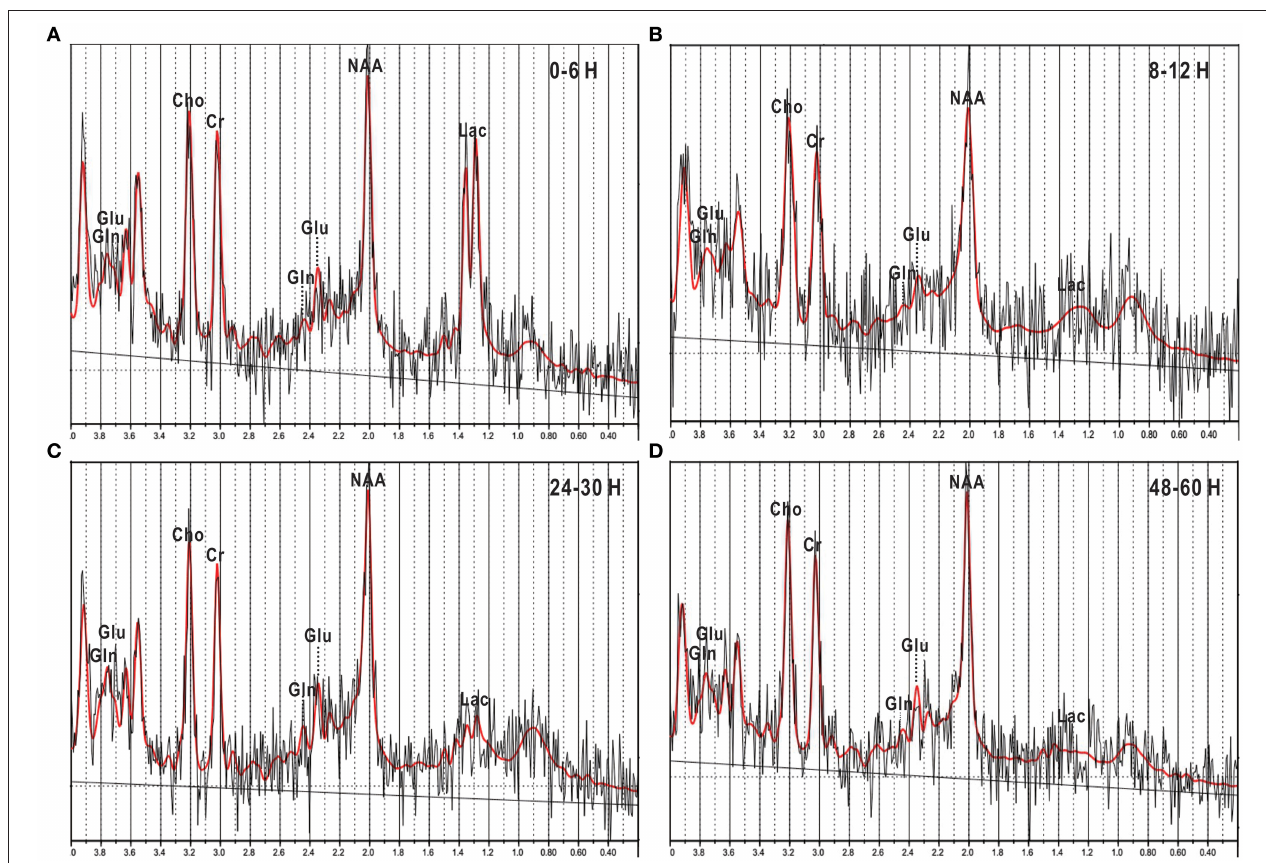
FIGURE 3 | 1 H-MRS images of newborn piglets at different times points after HI injury. (A–C) and (D) represented four different time points after HI operation: 0–6, 8–12, 24–30, and 48–60 h. In the spectra, the Glu peak was elevated at 0–6 h (A) , then slightly depressed at 8–12 h (B) , and thereafter elevated again at 24–30 h (C) , and 48–60 h (D) . However, the Gln peak did not show significant changes in the above image. Glu, glutamate; Gln, glutamine; NAA, N-acetylaspartate; Lac, lactate; Cho, choline; Cr, creatine.